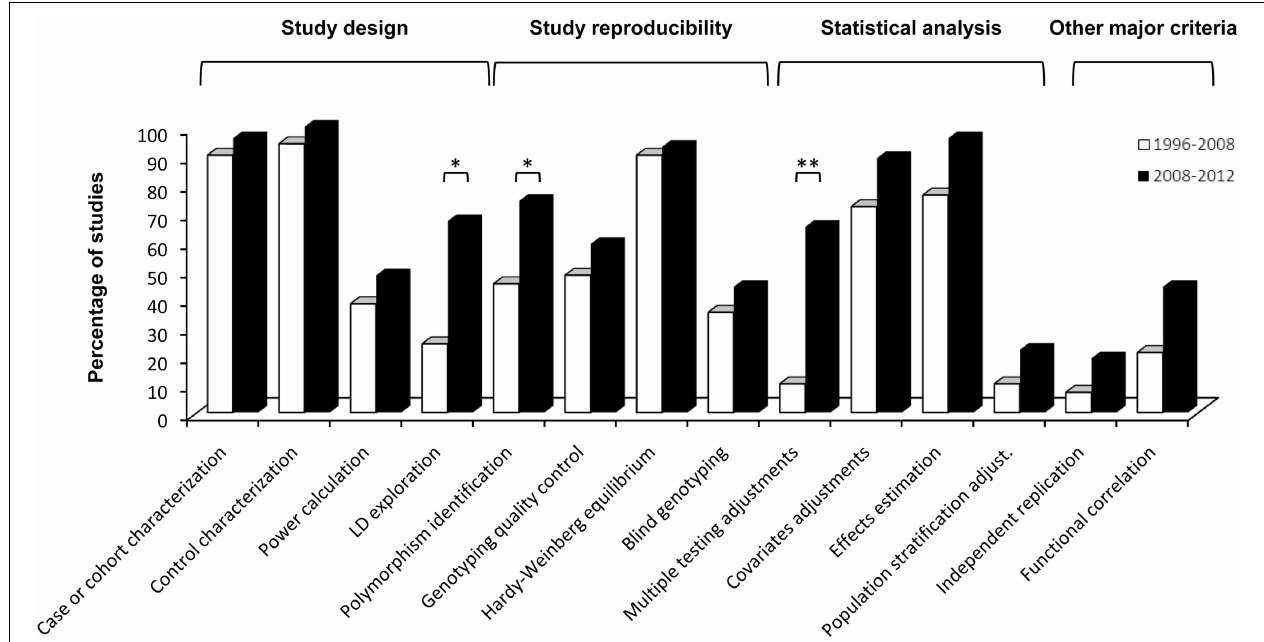
FIGURE 1 | Histogram comparing quality control scores of association studies in ARDS published from 1996 to 2008 (taken from Flores et al., 2008) and from 2008 until present. Statistically significant improvements